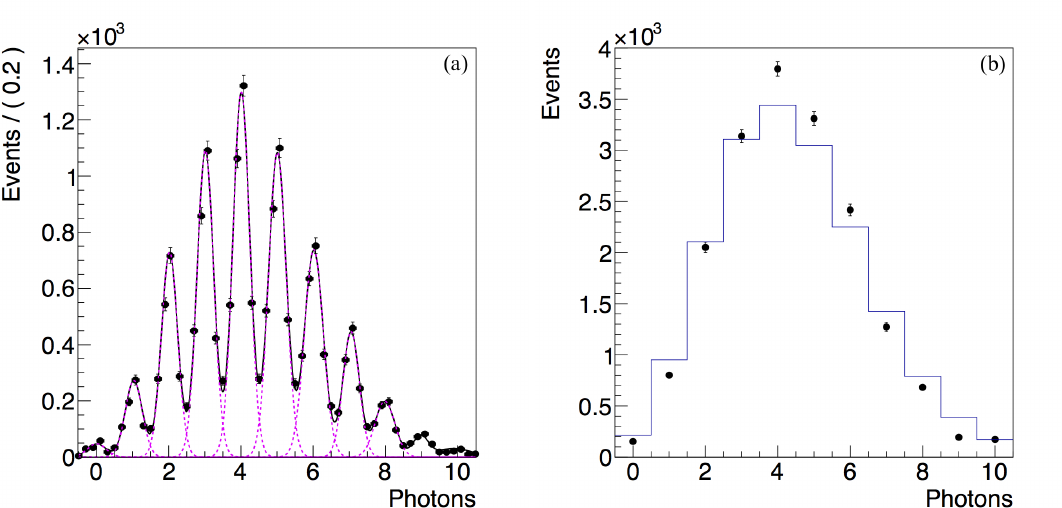
Figure 6. ( a ) Spectrum of the low photon flux detected by the SiPM prototype. The histogram is fit with a multi-gaussian fit (continuous line) with separately fitted areas (dotted line); ( b ) Statistical distributions of the number of events (area) of each peak in the spectrum and theoretical Poisson